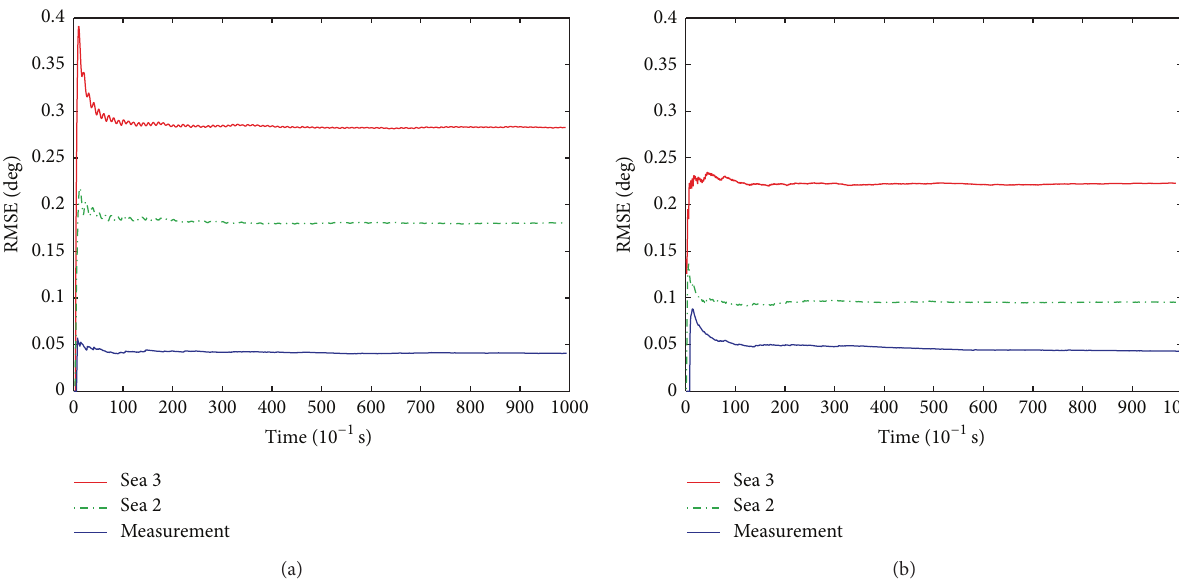
Figure 8: RMSE of (a) roll and (b) pitch under simulated data of sea states 2 and 3 and measured